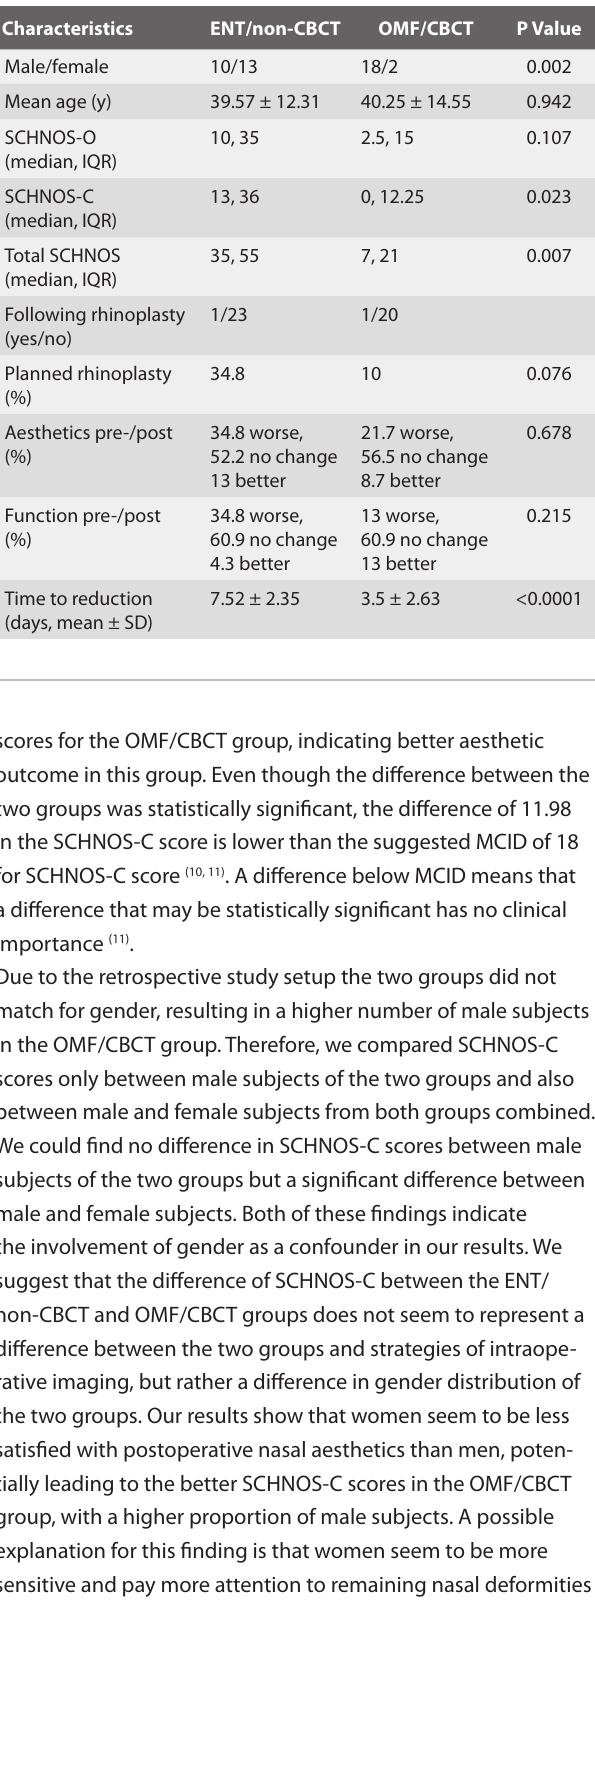
Table 2. Comparison of the measurements between ENT patients treated without intraoperative CBCT and OMF patients treated with intraopera- tive CBCT.